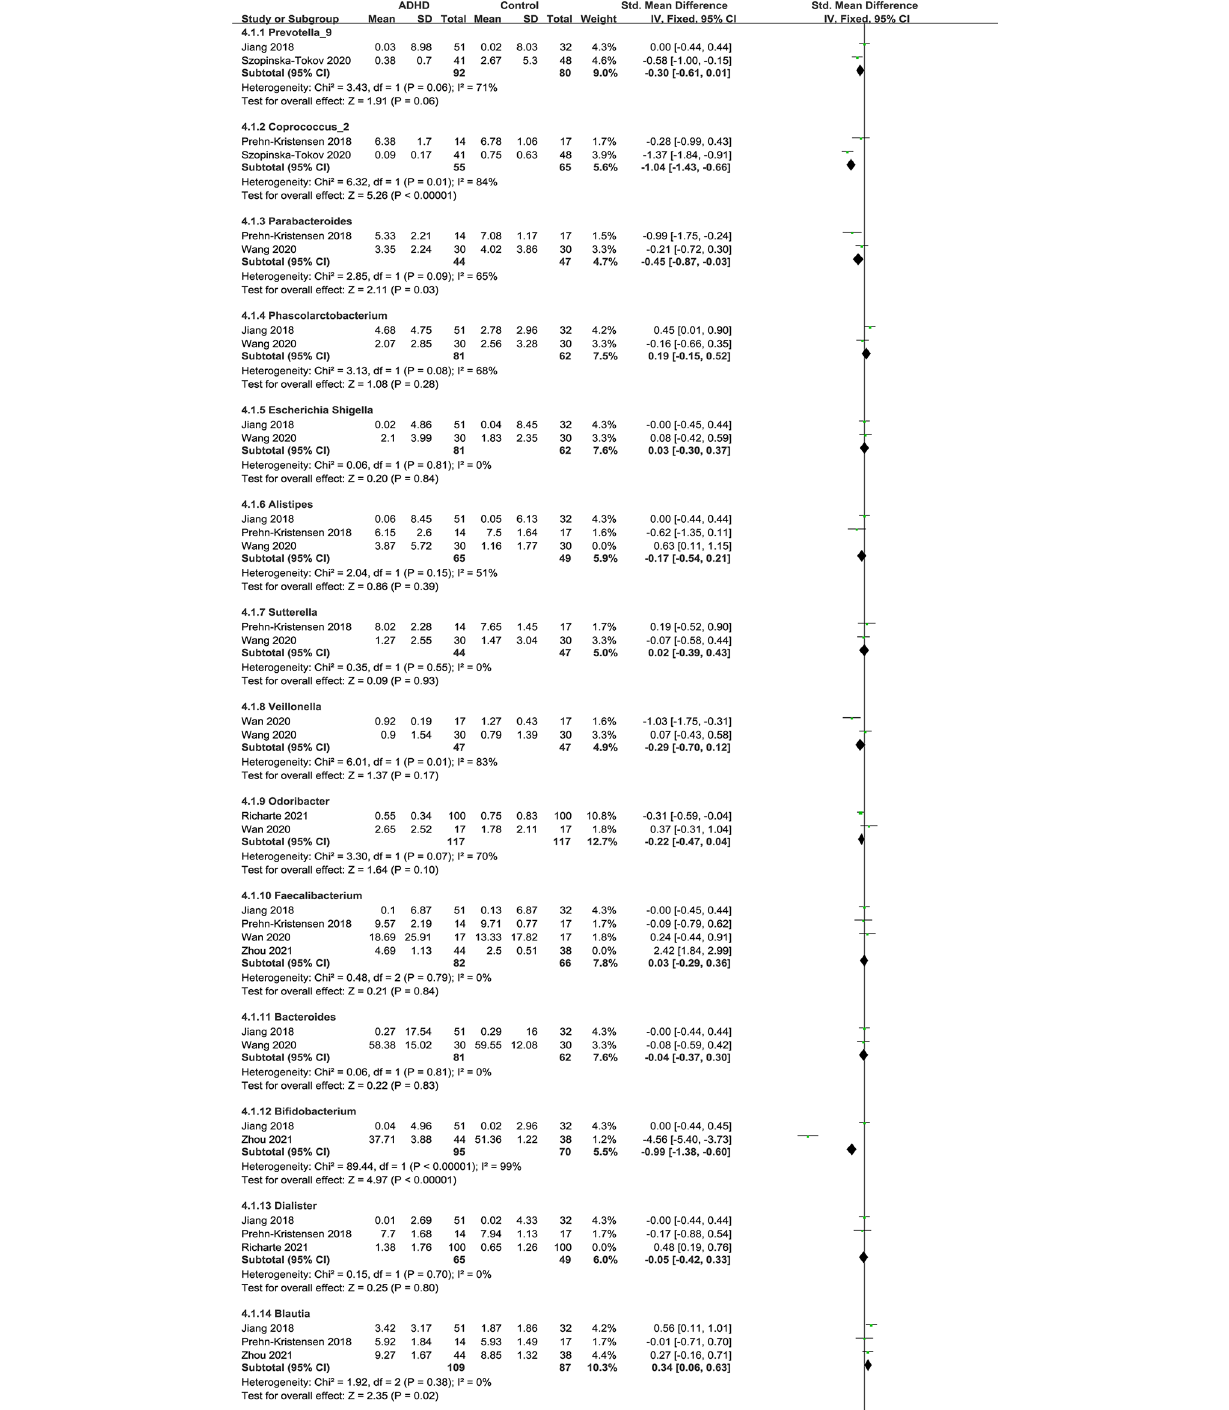
Frontiers in Endocrinology |